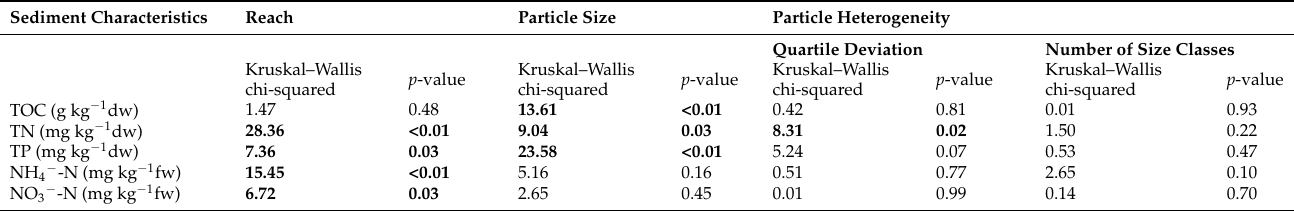
Table 2. Different sediment chemical parameters under different particle sizes and heterogeneities and reaches as illustrated by the Kruskal–Wallis test. Values in bold indicate significant differences ( p < 0.05). Sediment